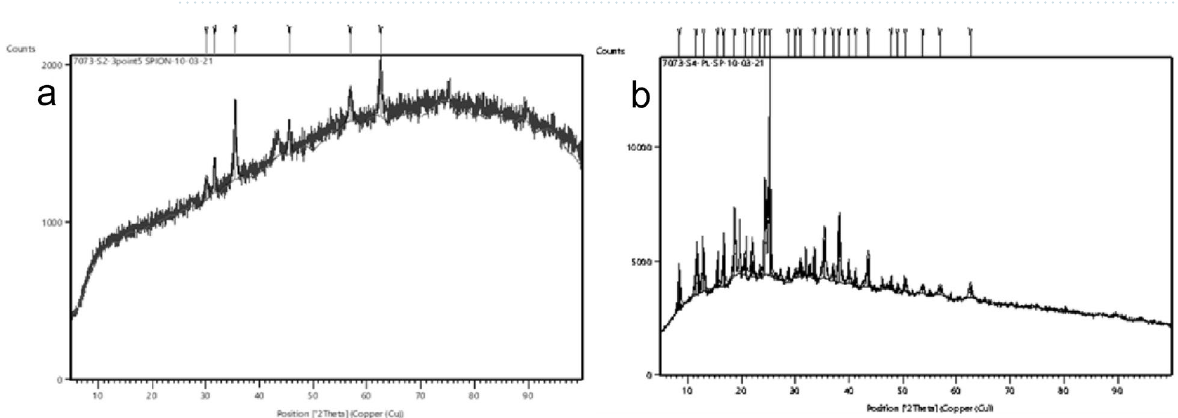
Figure 4. XRD analysis of ( a ) SPIONs; ( b ) Latex coated